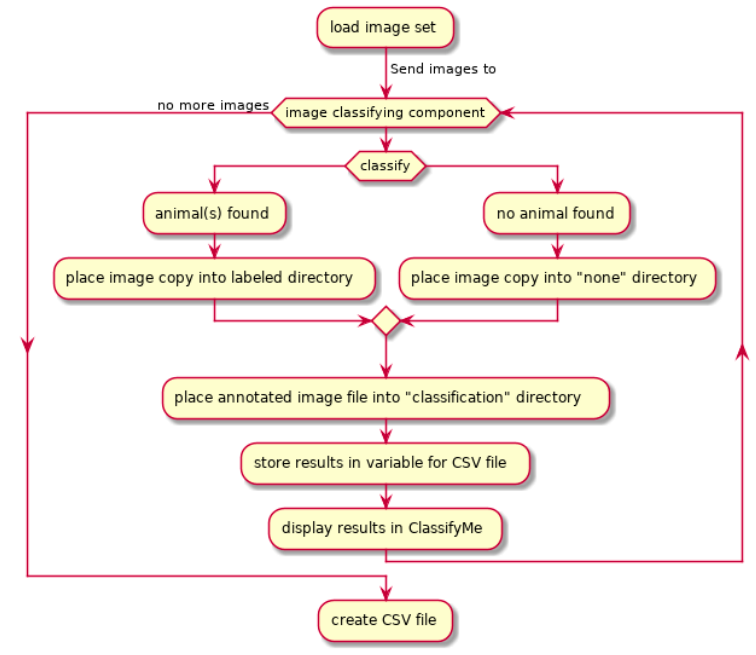
Figure 3. ClassifyMe Unified Modelling Language diagram for image classification.